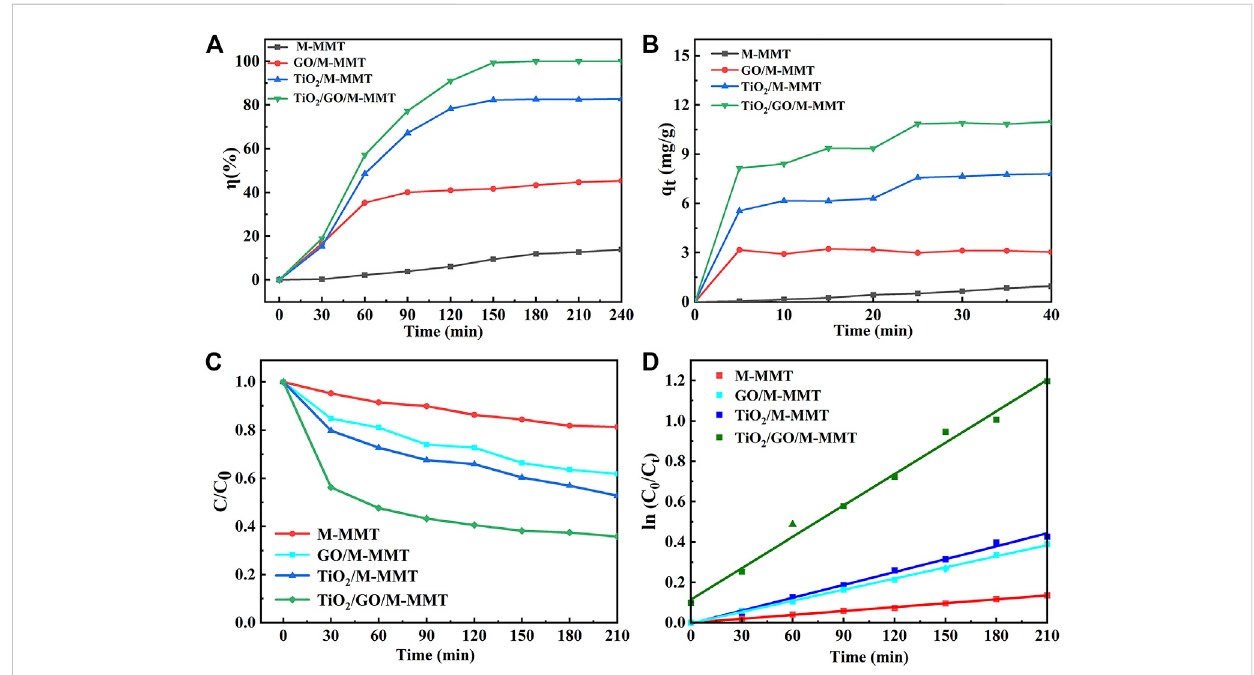
FIGURE 5 Photocatalytic performance curve of different photocatalyst. (A) The photocatalytic degradation rate curve; (B) The adsorption capacity curve; (C) Photodegradation concentration curve of MO; (D) Pseudo- fi rst-order kinetic equation fi tting diagram of different nanocomposite.